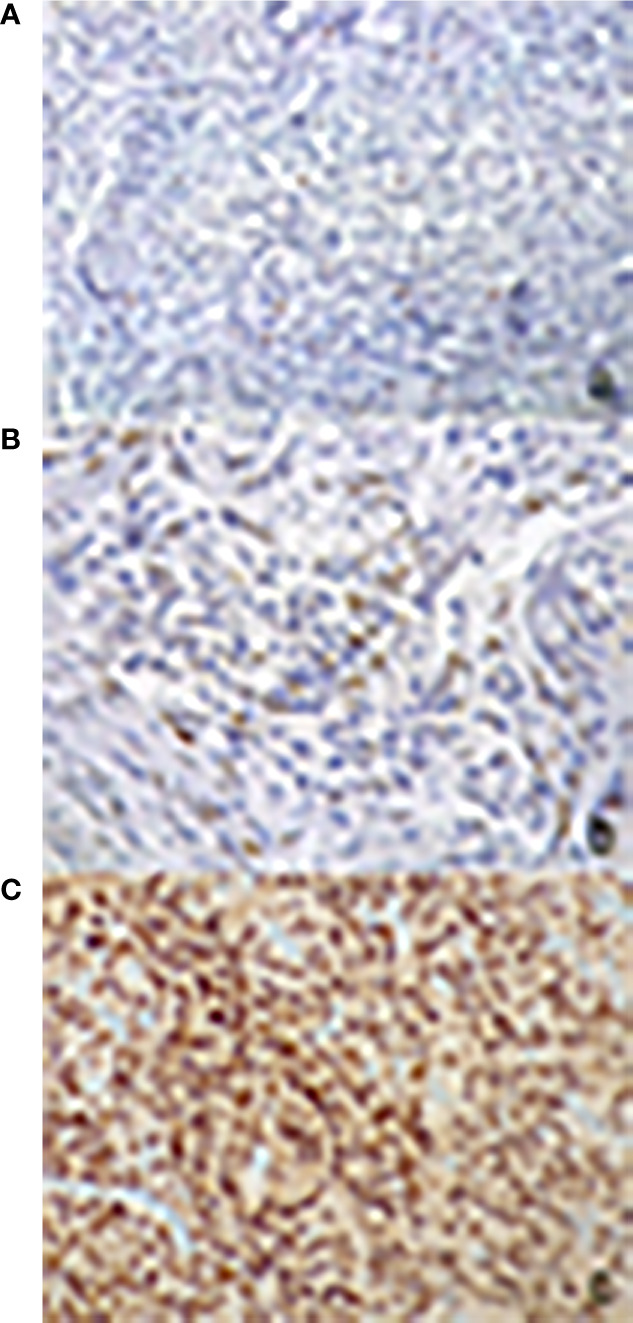
Immunohistochemical evaluation of progesterone receptor antibody expression: nuclear signal respectively in less than 1% (A), in 15% (B) and in 95% (C) of neoplastic cells (200× magnification).